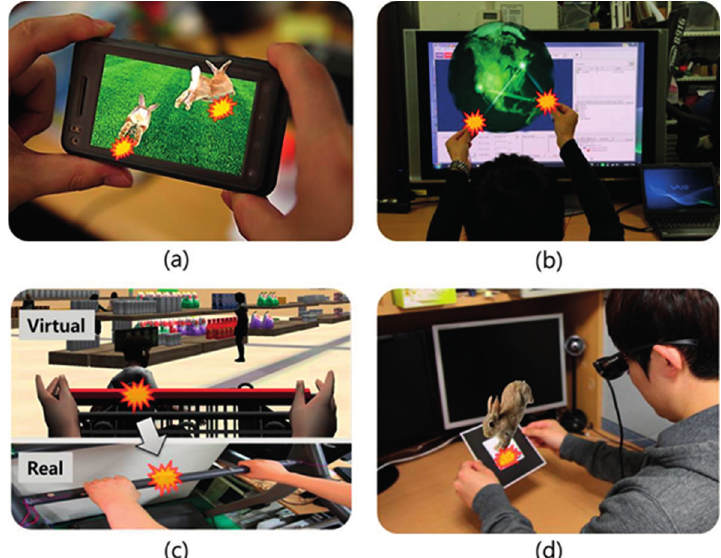
Figure 2. Possible applications of the “out of the body” phantom tactile sensation: two-handed/fingered interaction and feeling tactile sensations as if coming from the middle of: ( a ) a mobile device; ( b ) holographic imagery; ( c ) indirectly from a virtual object in a monitor; and ( d ) an augmented marker (e.g., seen through a head-mounted